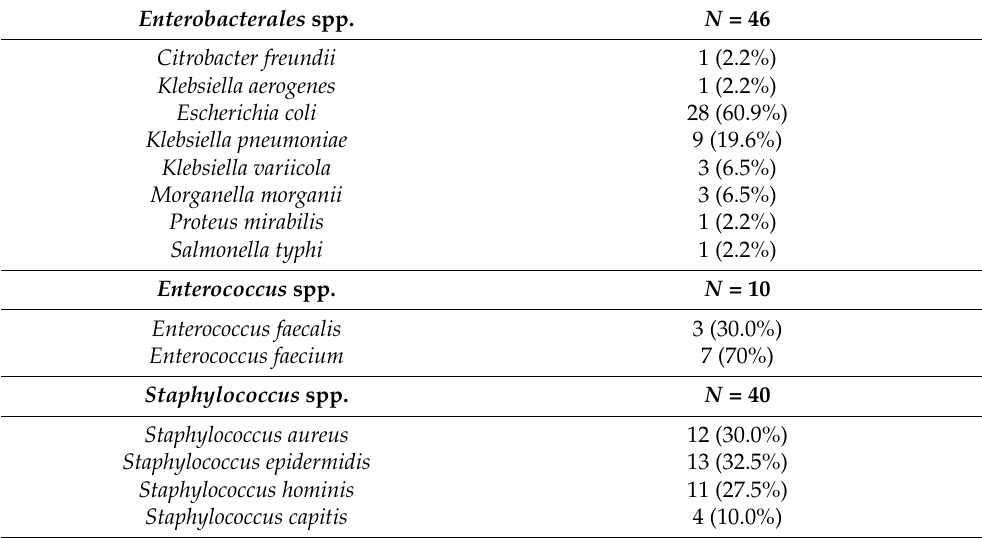
Table 2. Identified micro-organisms in included blood culture samples.